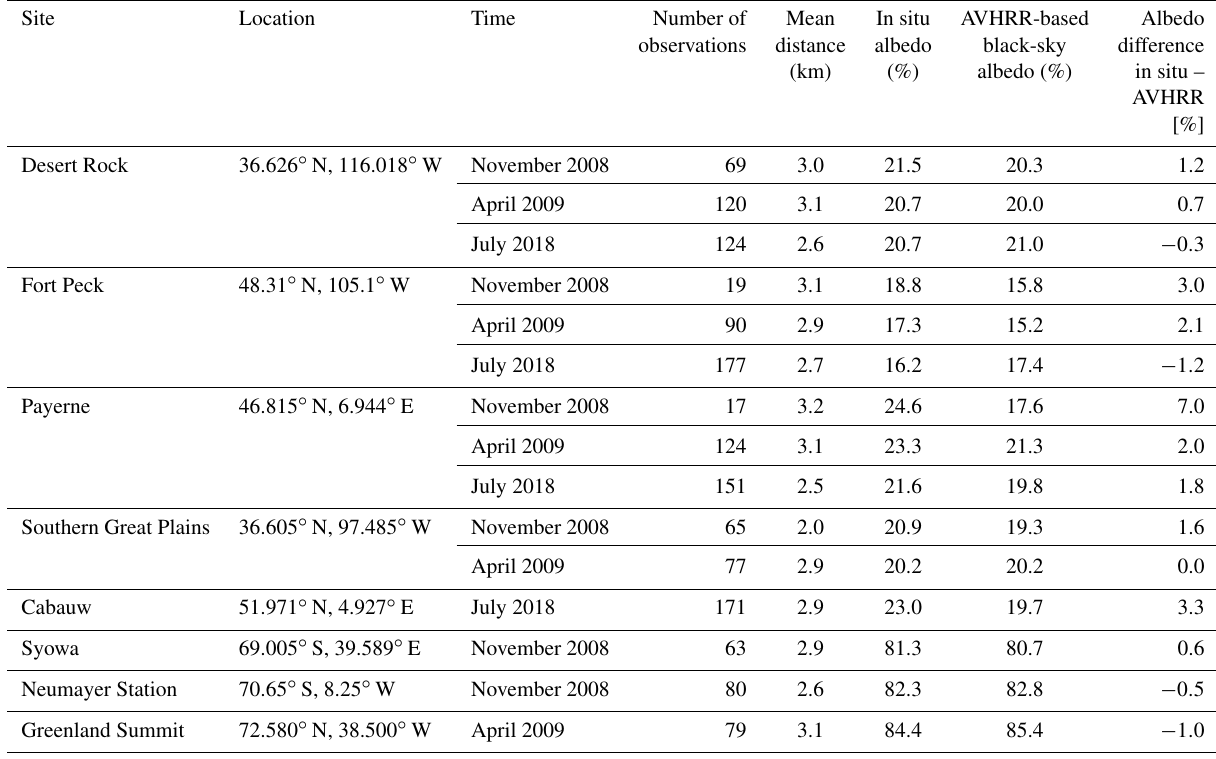
Table 3. Monthly mean black-sky surface albedo values based on AVHRR reflectance and CP values and the monthly mean values of the corresponding times of in situ surface albedo measurements for several BSRN in situ sites (König-Langlo et al., 2013; Driemel et al., 2018): Desert Rock (Augustine, 2009a, b, 2019a), Fort Peck (Augustine, 2009c, d, 2019b), Payerne (Vuilleumier, 2010a, b, 2019), Southern Great Plains (Long, 2009a, b), Cabauw (Knap, 2018), Syowa (Yamanouchi, 2010) and Neumayer Station (König-Langlo, 2009). Data from the Greenland Summit in situ site is also included (Steffen et al., 1996). The number of observations included in the mean value are given, as well as the mean distance of the satellite pixels from the in situ measurement